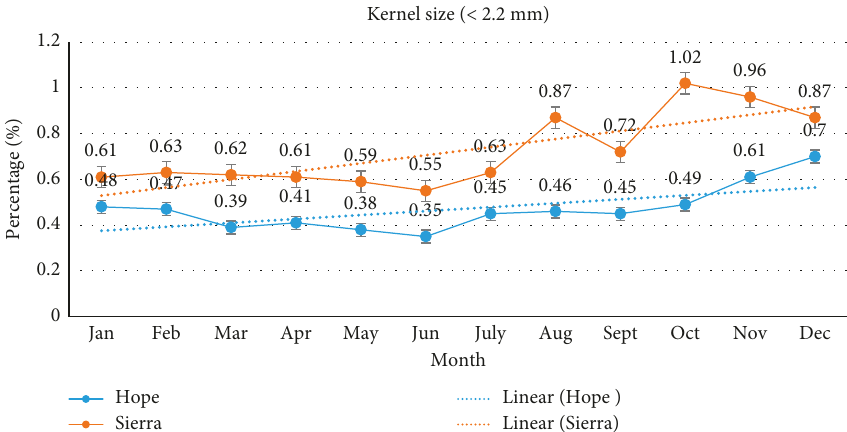
Figure 9: Comparison of < 2.2mm kernel size for Hope and Sierra malting barley varieties over the 12-month storage period.